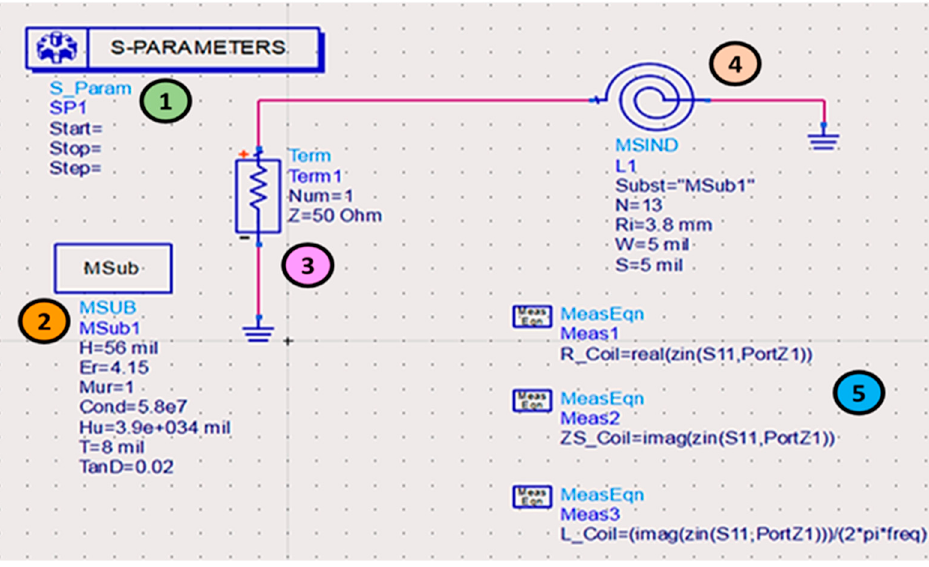
Figure 10. Coil form factor and efficiency optimization using ADS.